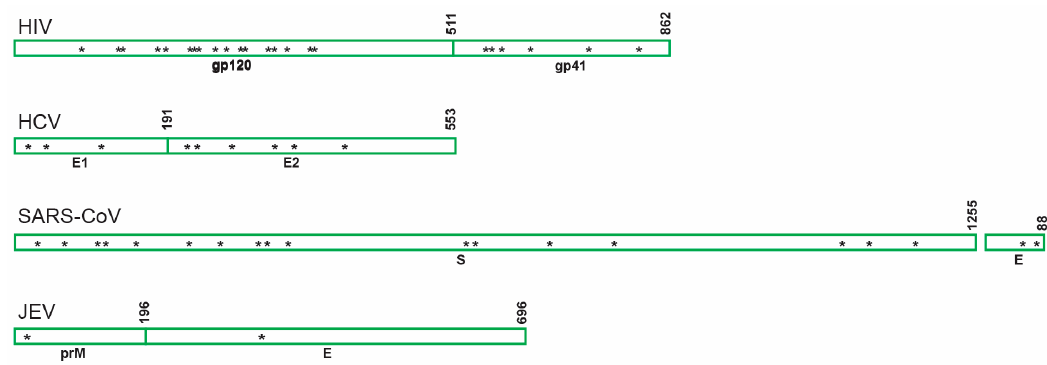
Figure 3. Schematic showing distribution of the predicted asparagine-linked glycosylation sites of envelope glycoproteins belonging to different viruses inhibited by GRFT. HIV: human immunodeficiency virus; HCV: hepatitis C virus; SARS-CoV: severe acute respiratory syndrome coronavirus; JEV: Japanese encephalitis virus; gp120: envelope glycoprotein gp120; gp41: transmembrane protein gp41; E1 and E2: envelope glycoprotein 1 and 2 respectively; S: spyke protein; E: envelope glycoprotein; prM: premembrane gycoprotein. Table 2. Effective concentrations to inhibit 50% of virus infection (EC 50 ) of GRFT against different viruses. Sample Virus a Target Cell b EC 50 (nM) Ref. 0.043